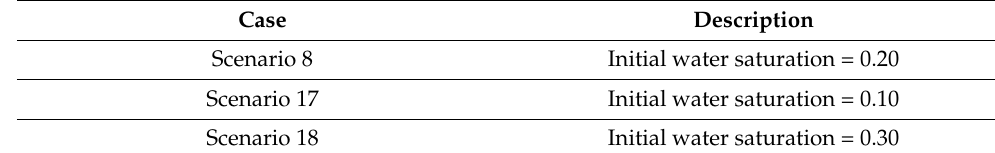
Table 7. Scenarios of varying initial water saturation.